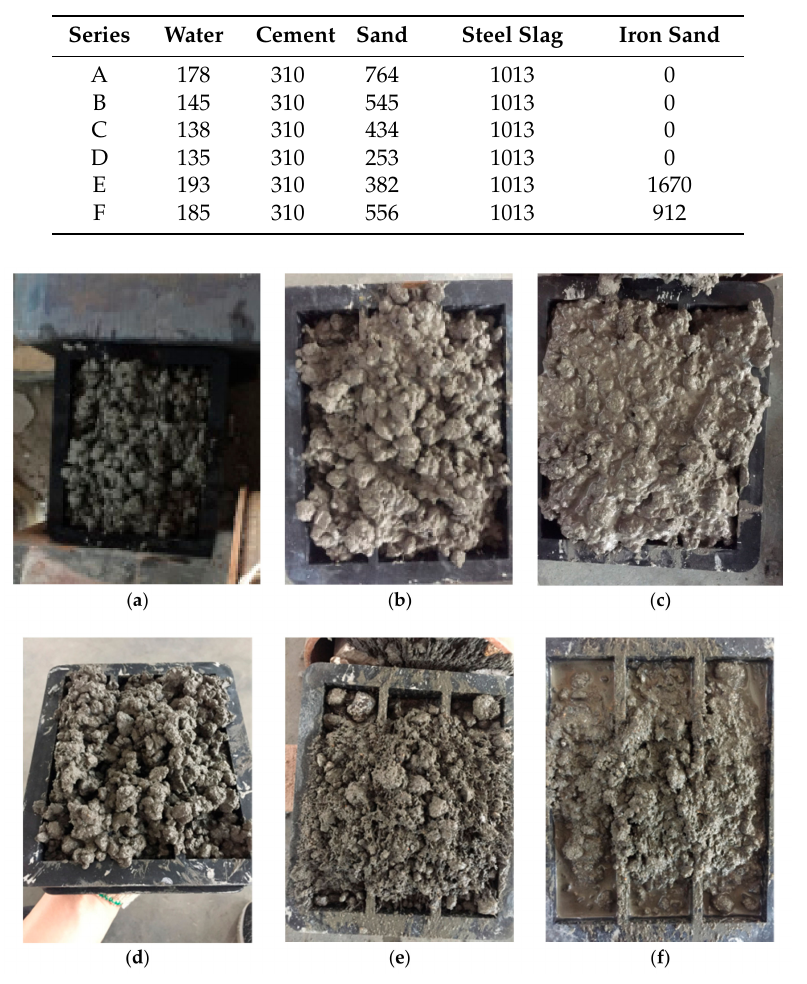
Table 7. Mix proportion of the magnetically driven mortar (by weight kg/m 3 ).